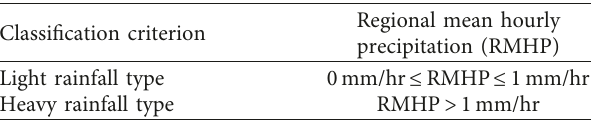
Figure 7: The statistical results of average effective radius of hydrometers within TPV category cloud clusters over each key region: (a) effective radius of ice crystal particles; (b) effective radius of water-droplet particles (black legend represents climatological results, X -axis represents altitude (unit: km), and Y- axis represents average effective radius (unit: μ Table 1: The classification criteria of TPV category cloud clusters based on the difference of precipitation intensity.